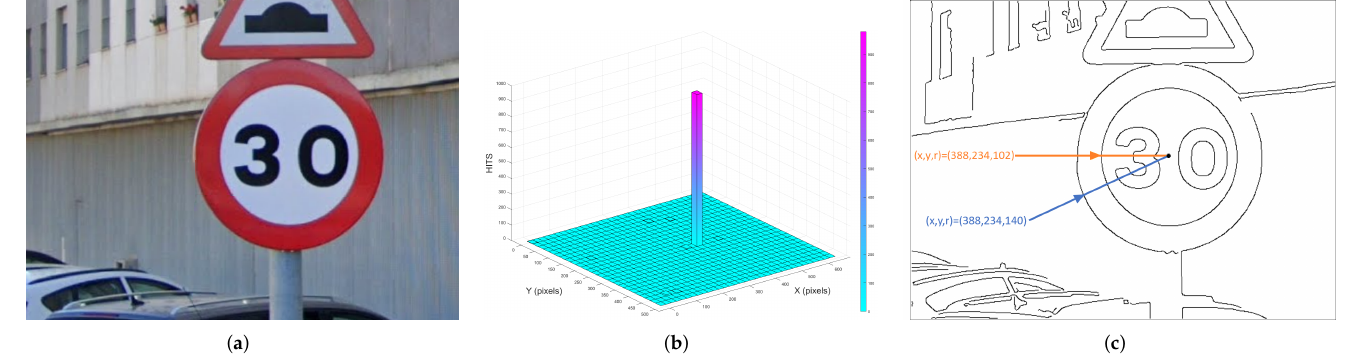
Figure 15. Real-image sample containing an object with two concentric circles ( a ), hit distribution as function of the centers detected ( b ), and circle parameter comparison over the edge image ( c